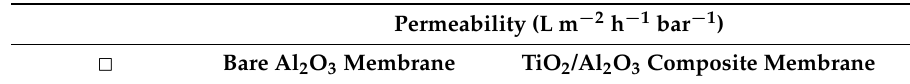
Table 1. Comparison of pure water permeability for bare Al 2 O 3 membrane and Poly(oxyethylene methacrylate) (POEM)-directed TiO 2 /Al 2 O 3 composite membrane during filtration (with and without ultraviolet (UV) illumination).